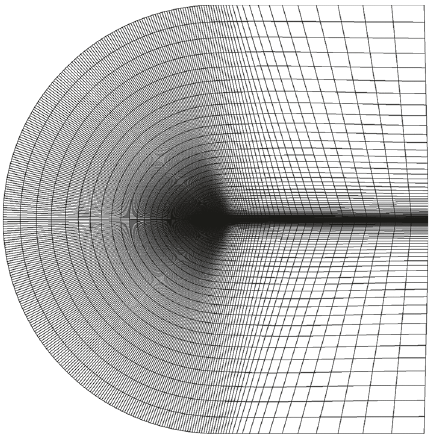
Figure 5: Far-field of initial algebraic Euler and Navier–Stokes